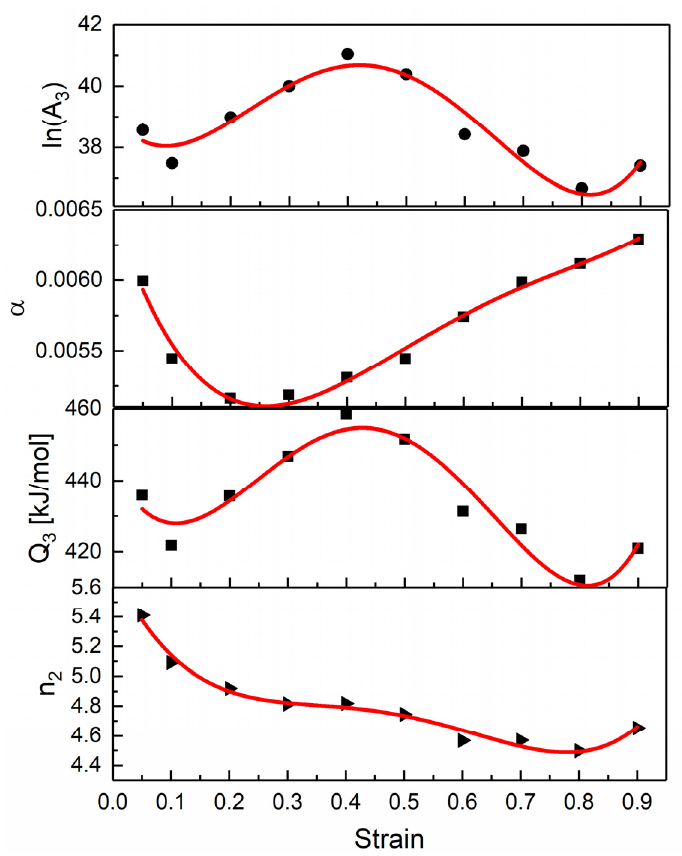
Figure 5. The dependence of the constitutive model coefficients on the true stress: dots are calculation values; lines are the polynomial approximation accordingly Equations (6)–(9).